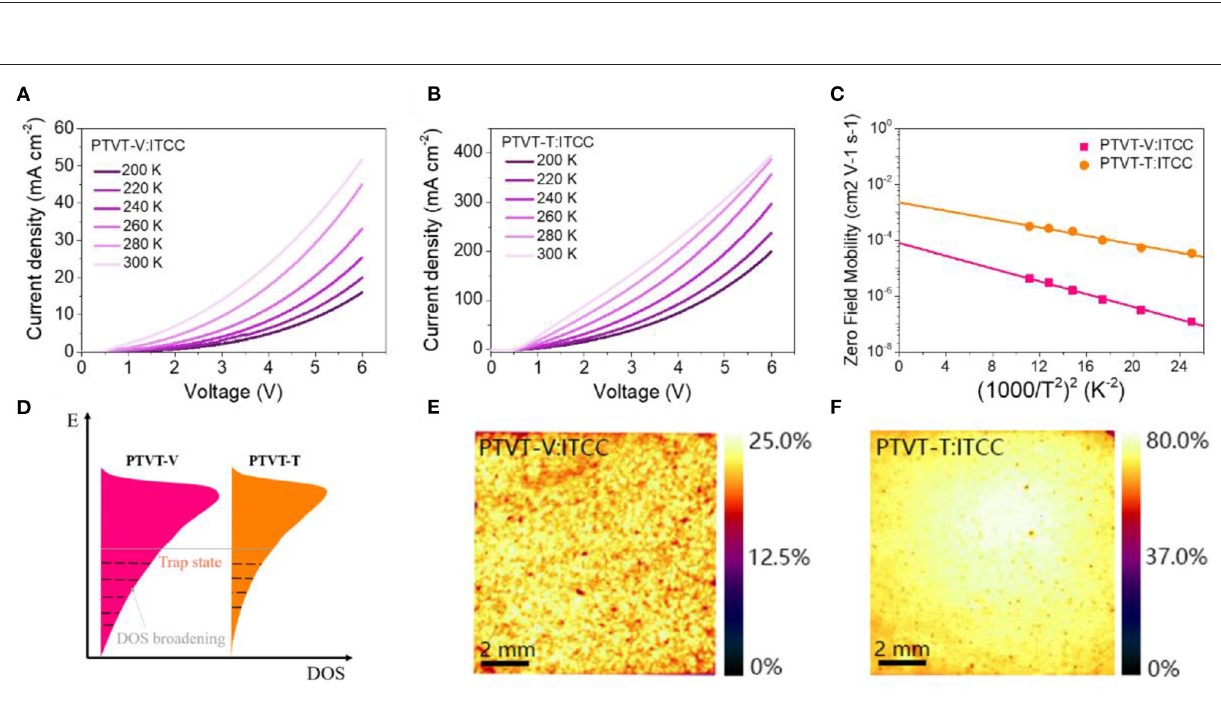
Frontiers in Chemistry |